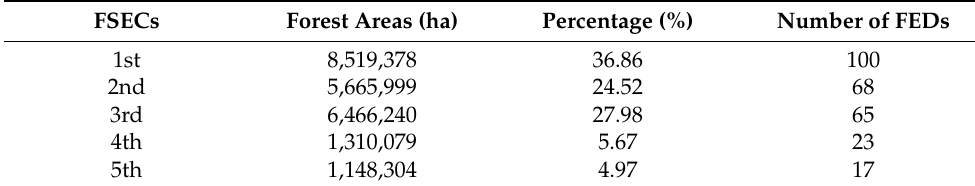
Table 1. Distribution of Turkey’s forests according to FSECs. FSECs Forest Areas (ha) Percentage (%)